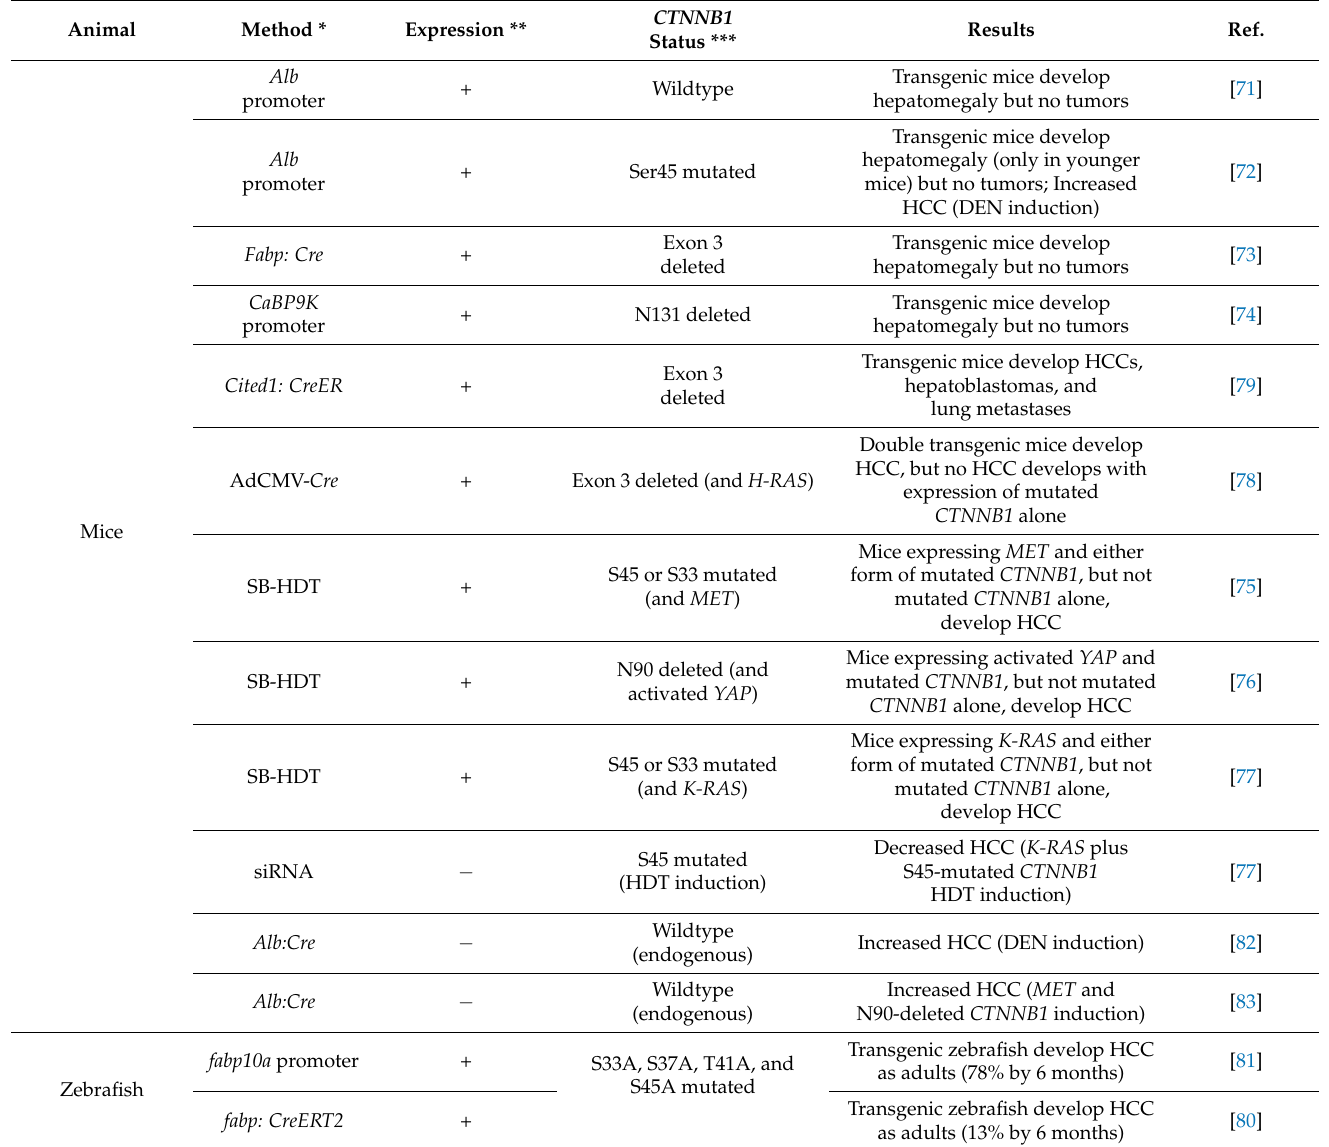
Table 3. HCC animal models with CTNNB1